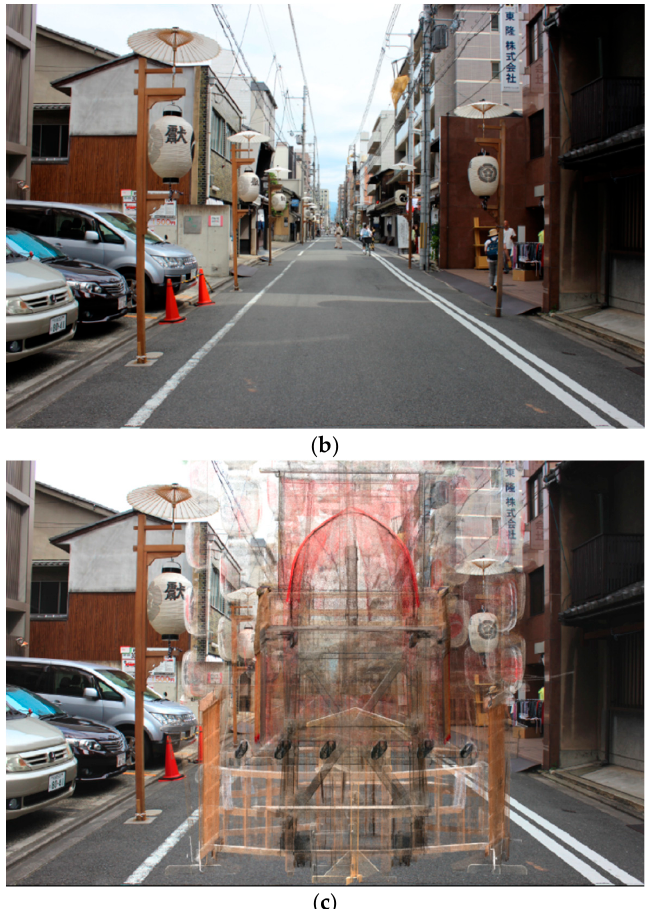
Figure 2. Comparison of the conventional transparent visualization based on Stochastic Point-Based Rendering (SPBR) and the proposed fused transparent visualization: ( a ) transparent visualization based on SPBR, ( b ) background photographic image of Shinmachi Street, ( c ) fused transparent visualization of the point cloud of Hachiman-Yama float with its background photographic image.